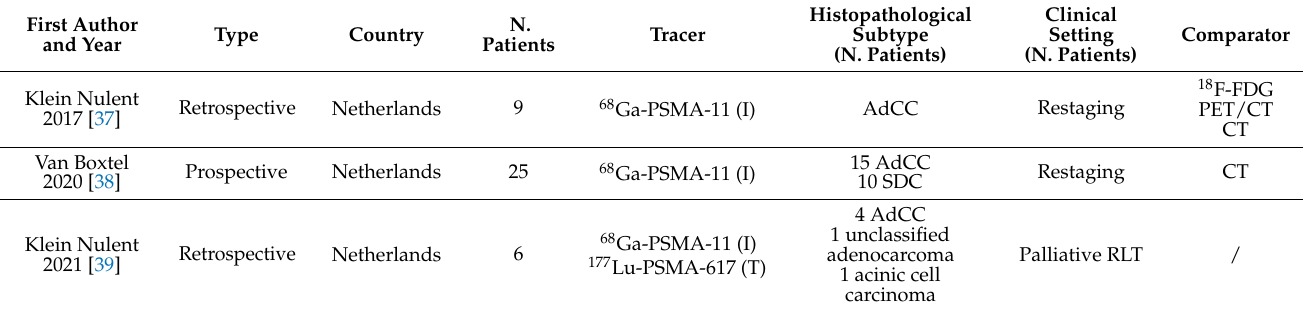
Table 2. Characteristics of the included studies which employed PSMA radioligands in salivary gland